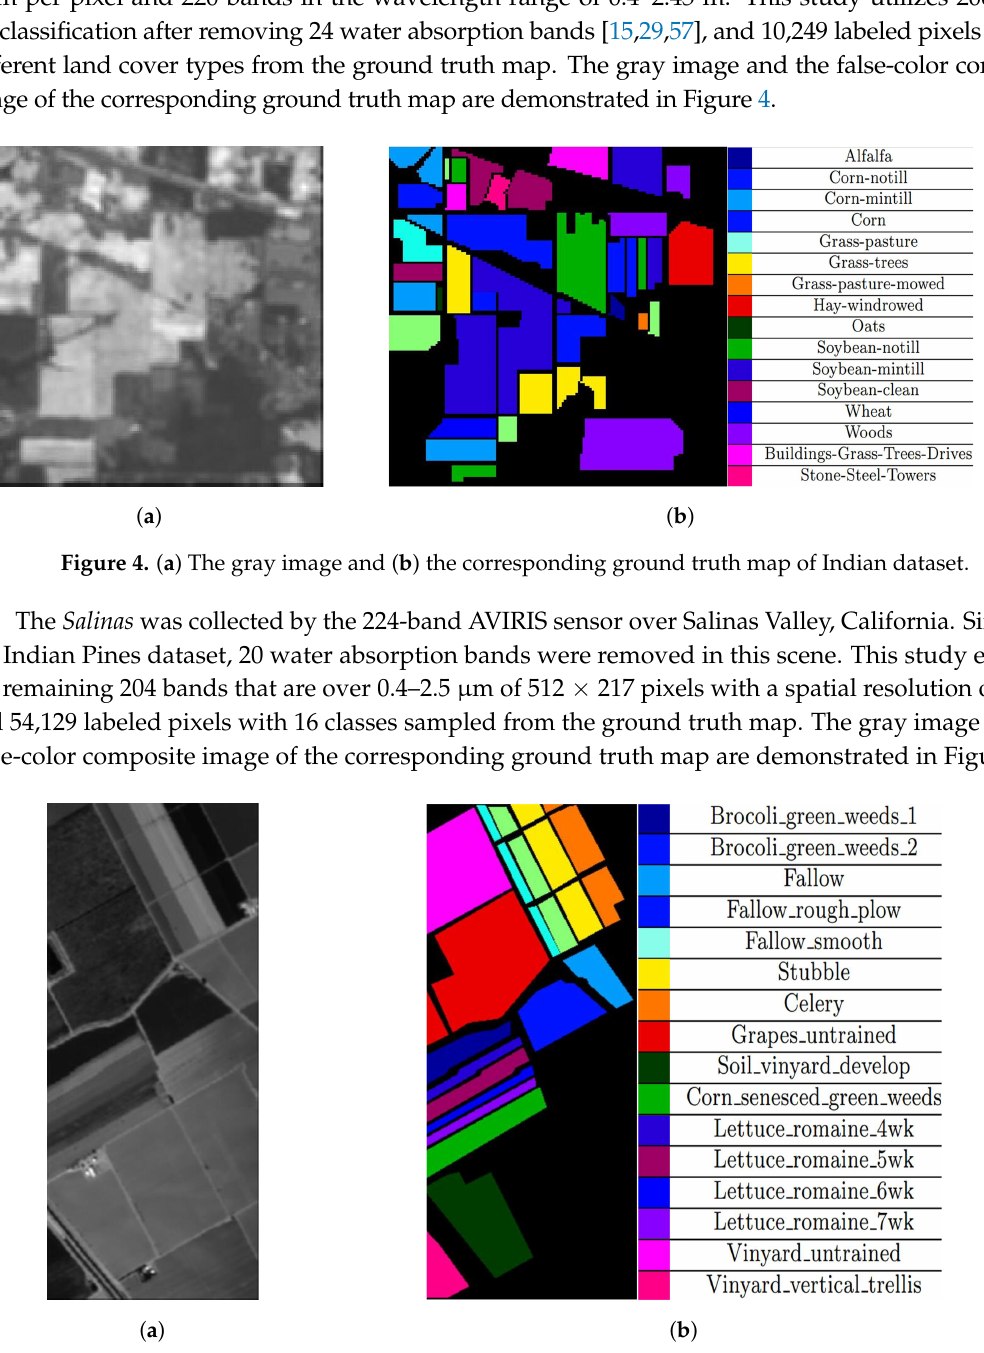
Figure 5. ( a ) The gray image and ( b ) the corresponding ground truth map of Salinas